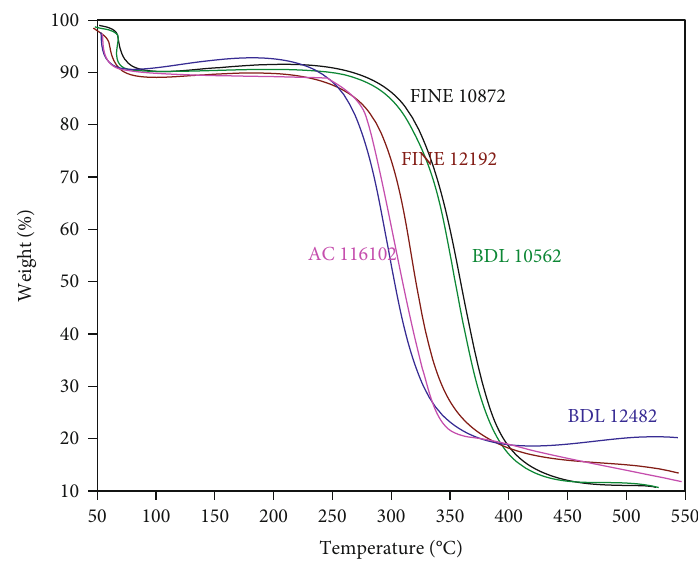
Figure 2: A comparison of nontreated and bleached PALF using thermal gradient analysis (TGA). Table 1: Crystallinity indexes of various